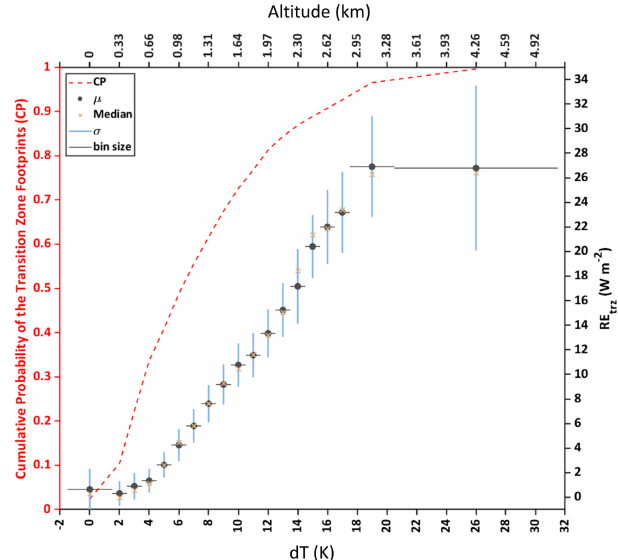
Figure 5. Cumulative probability (left axis) and RE trz (right) of the transition-zone footprints analyzed as a function of d T . The verti- cal blue lines, black circles, and yellow crosses indicate the standard deviation ( σ ), mean ( µ ), and median of the RE trz values in each d T bin, respectively. The horizontal black lines show the width of each d T bin. The bottom x axis shows the center of each d T bin, and the top x axis shows the height associated with the d T value given in the bottom axis. The altitudes given in this figure are calculated follow- ing the estimates of the mean tropospheric temperature lapse rate for the study area (6.1Kkm − 1 ) given in Mokhov and Akperov